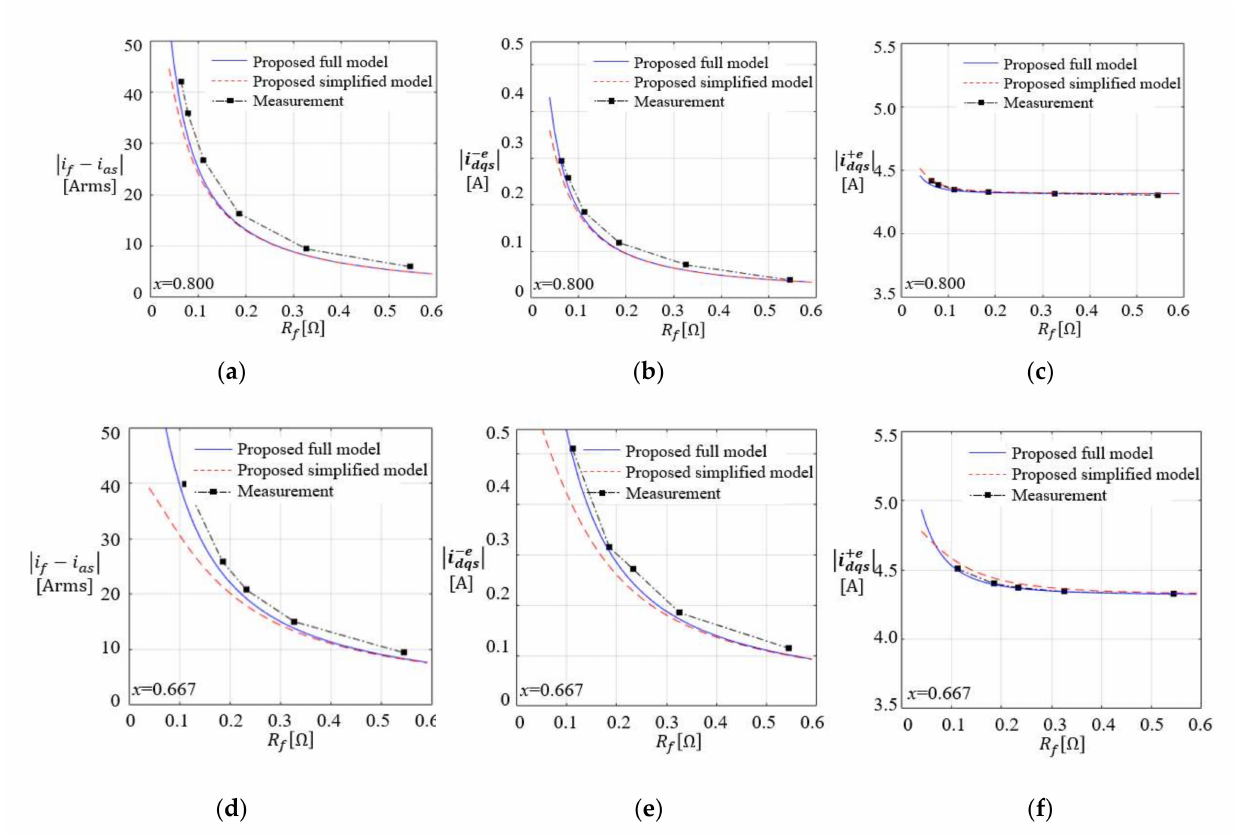
Figure 11. Comparison results between experiment and simulations with varying fault resistance, x = 0.8: ( a ) fault resistor current, ( b ) negative sequence current, and ( c ) positive sequence current and x = 0.667: ( d ) fault resistor current, ( e ) negative sequence current, and ( f ) positive sequence